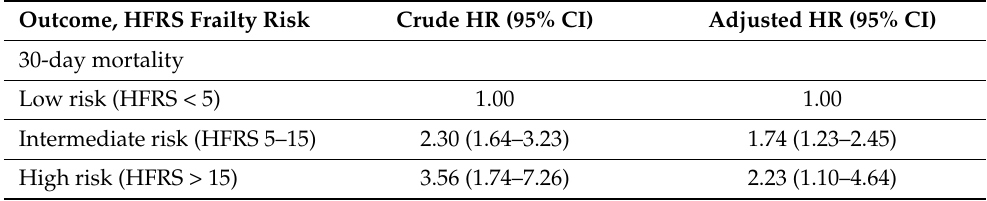
Table 5. Cox proportional hazard risk models for association of HFRS risk with 30-day mortality and readmissions. Models adjusted for age, sex, Charlson index and socioeconomic